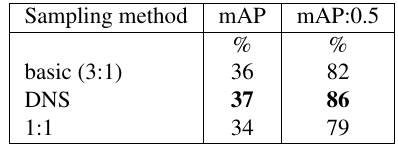
Table 7. Hard-mining batch sampling method